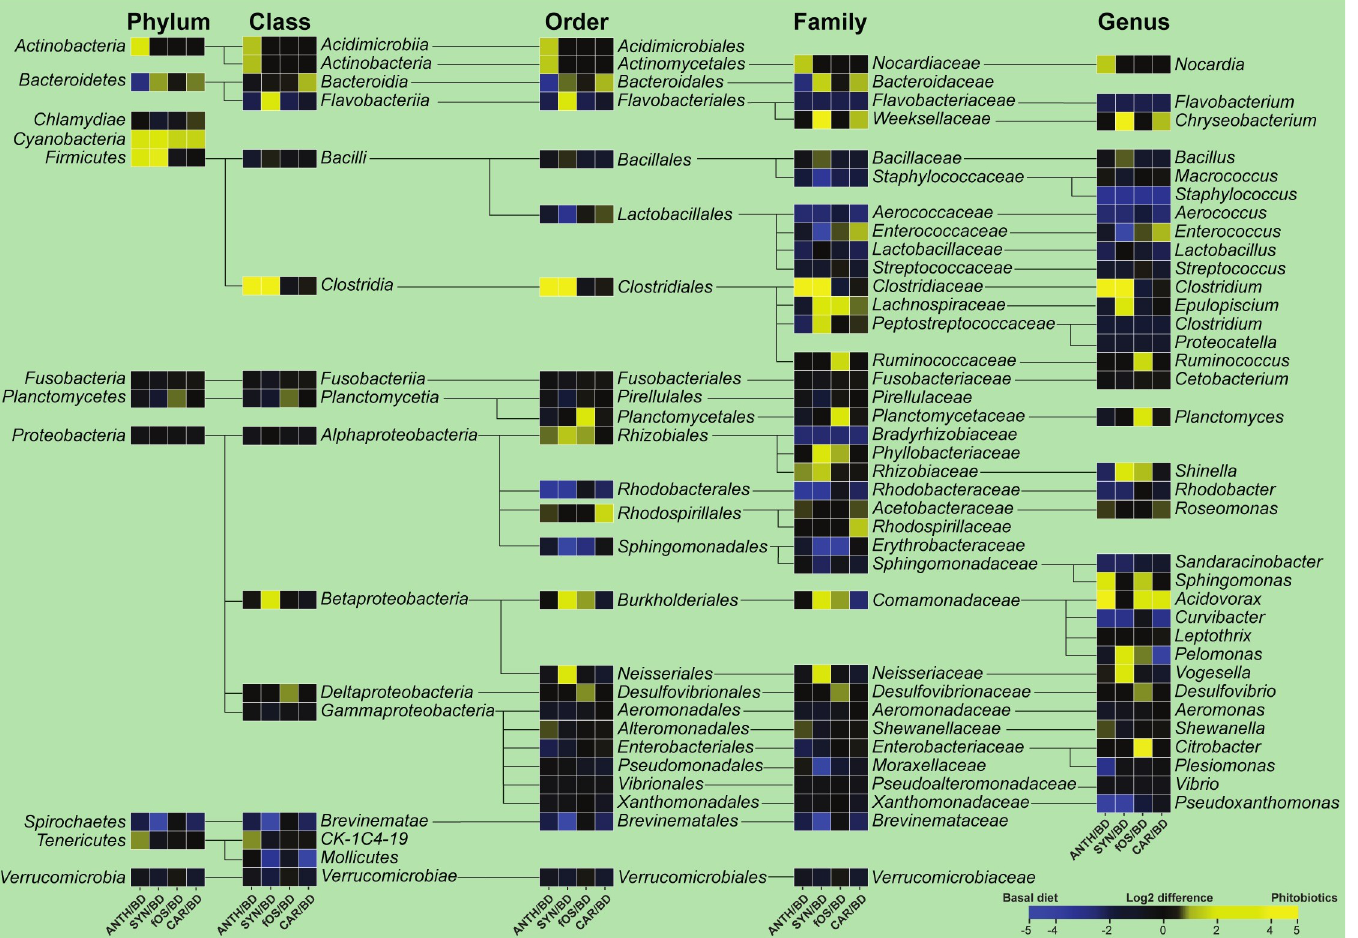
Fig 4. The composition of the healthy Cyprinus carpio GIT symbiome was mapped. Abundance variations were observed in key taxa. A composite heat map was created to note the pronounced distortions in the taxonomic profiles based on the normalized abundance data (ANTH/SYN/fOS/CAR vs. BD). BD represents fish that received a basal diet, which served as a negative control with no dietary supplement or the following dietary treatments as supplemented phytonutrients feed: BD+1% anthocyanins (ANTH) provided by Hungarian sour cherry extract, BD+1% synbiotics (SYN) provided by fermented corn, BD+1% fermentable oligosaccharides (fOS) provided by Hungarian sweet red pepper seed extract, and BD+1% carotenoids (CAR) provided by Hungarian sweet red pepper pulp extract. The extents of the differences are illustrated on the composite heatmap with gradient colours, where the yellow scale shows the taxa found at higher abundances in the phytonutrients-treated specimens (log2(phytonutrients/BD) > 0) and the blue scale indicates a higher taxa abundance in the non-treated controls (log2 (phytonutrients/BD) < 0). Shifts in the abundances of 122 taxa due to phytonutrients can be observed.